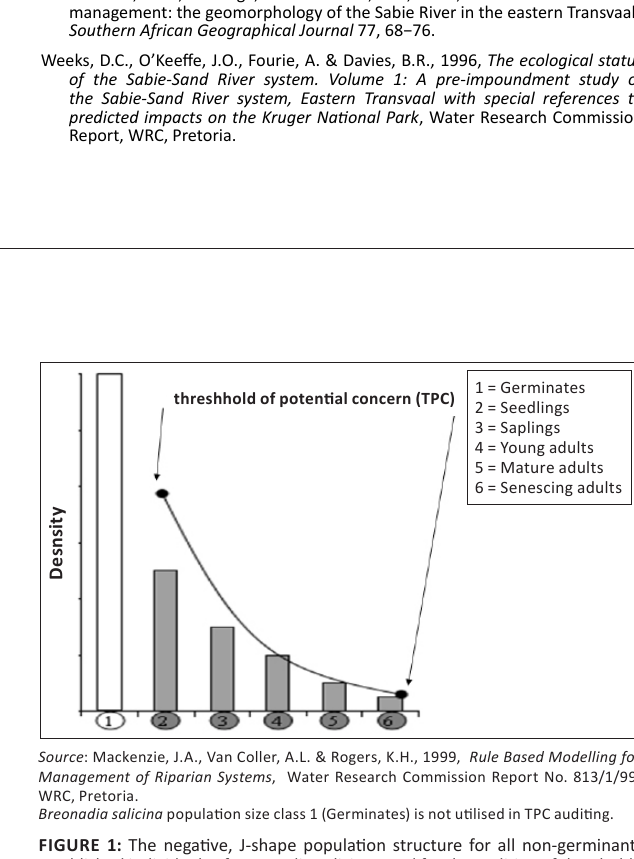
FIGURE 1: The negative, J-shape population structure for all non-germinant, established individuals of Breonadia salicina , used for the auditing of thresholds of potential